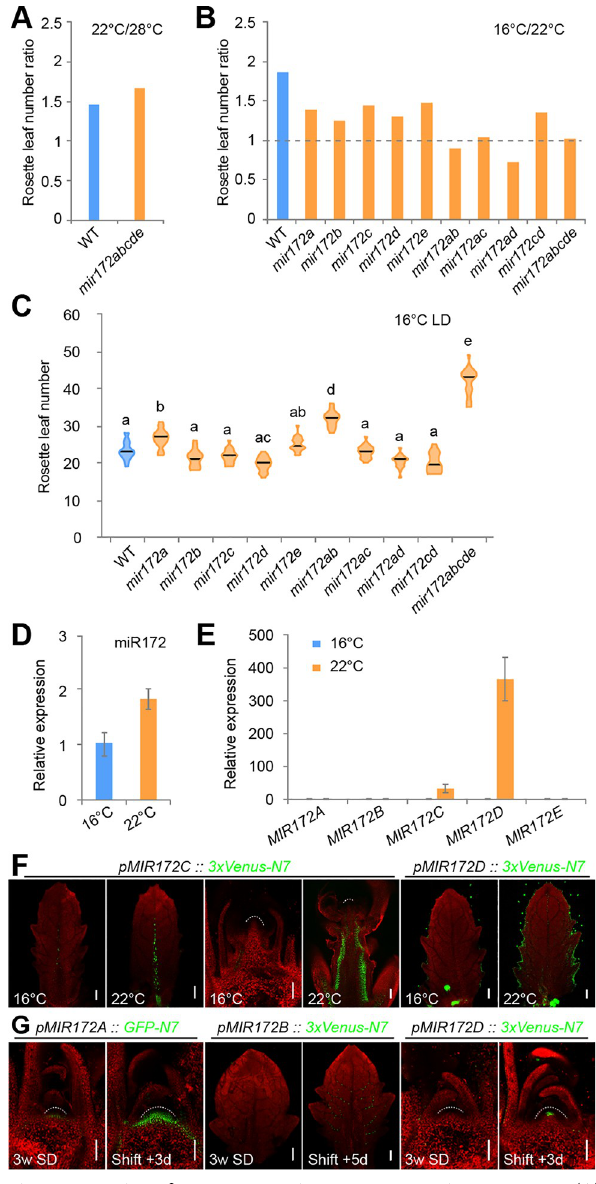
Fig 7. Expression of MIR172 genes in response to environment cues. (A) Comparison of the flowering time of WT and the mir172abcde mutants grown at 22˚C and 28˚C in long days. Rosette number ratio was calculated by the mean value at 22˚C divided by that at 28˚C. (B) Comparison of the flowering time of WT and the mir172 mutants grown at 16˚C and 22˚C in long days. Rosette number ratio was determined by the mean value at 16˚C divided by that at 22˚C. (C) Quantification of flowering time phenotype of the mir172 mutants at 16˚C in long days. Lines show mean ( n = 18– 24). The statistically significant differences are determined by ordinary one-way ANOVA ( p < 0.05). See also S1 and S4 Tables. (D and E) Expression of miR172 (D) and MIR172 genes (E) at 16˚C and 22˚C in long days. Expression was normalized to TUB . Two technical replicates for each biological replicate ( n = 3) were performed. Error bars represent SD. (F) Analyses of MIR172C and MIR172D reporters in the shoot apices. Plants were grown at 16˚C in long days. (G) Expression of MIR172A , MIR172B , and MIR172D reporters in response to photoperiod. The plants were grown in short days (SD) for 3 weeks and shifted to long days (shift + 3 d or 5 d). The same confocal settings were used for scanning for each reporter line (F and G). Dash lines mark the SAM. See also S13 Fig. The data underlying this figure are included in S1 Data. LD, long days; SAM, shoot apical meristem; SD, short days; TUB, β -TUBULIN-2 ; WT, wild type.